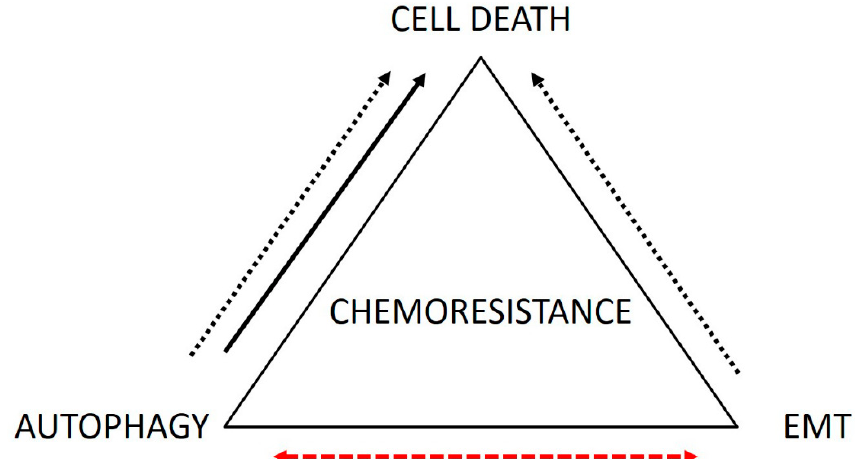
Figure 3. The mutual relationship between autophagy, epithelial mesenchymal transition (EMT), and apoptosis as three selected chemoresistence mechanisms in malignant colorectal carcinoma (CRC) cells. Resistant CRC cells upregulate autophagy, which acts to suppress apoptosis (dotted line). Alternatively, autophagy may contribute to apoptosis of these cells (full line). EMT in CRC cells inhibits their ability to undergo apoptosis (dotted line). Autophagy and EMT appear to be mutually exclusive events in CRC cells (dashed